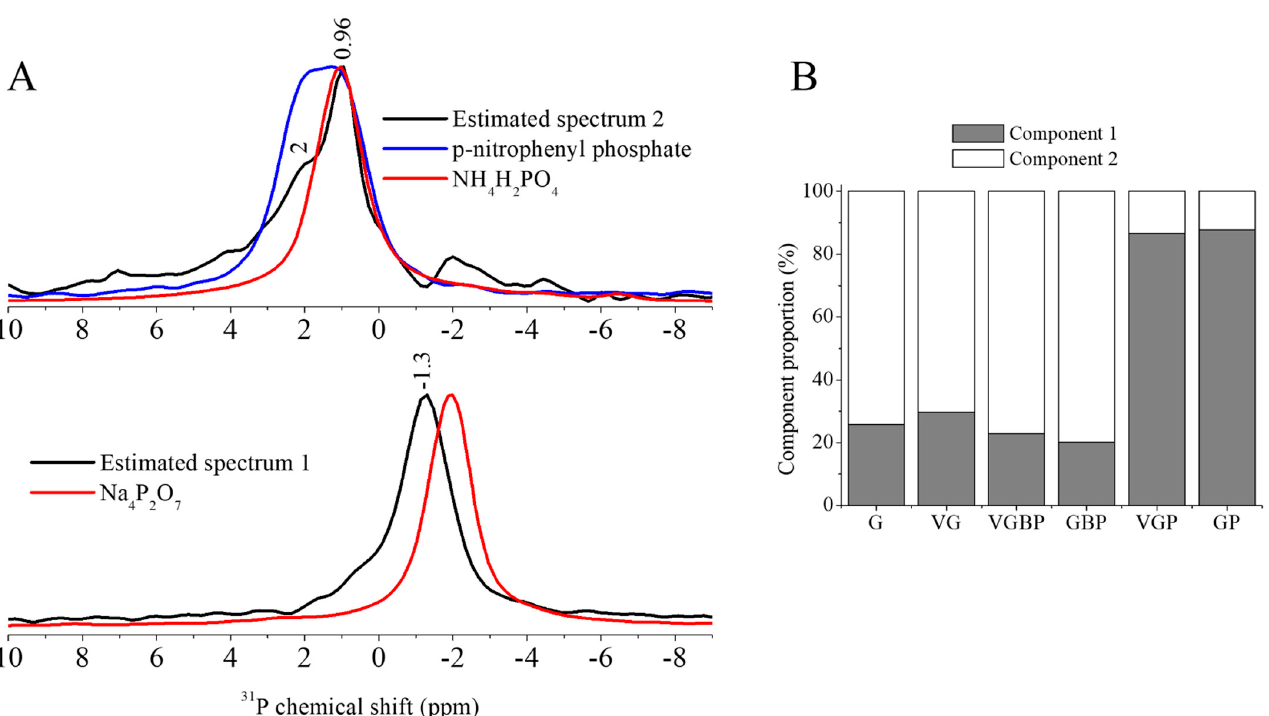
Figure 5. Multivariate curve resolution results obtained from the 31 P NMR spectra showing the two component solutions. ( A ): estimated component spectra; discontinued lines show the 31 P NMR spec- tra of 31 P standards. ( B ): estimated concentrations. G: grass compost; VG: grass vermicompost; GP: grass + phosphate compost; VGP: grass + phosphate vermicompost; GBP: grass + biochar + phos- phate compost; and VGBP: grass + biochar + phosphate vermicompost.